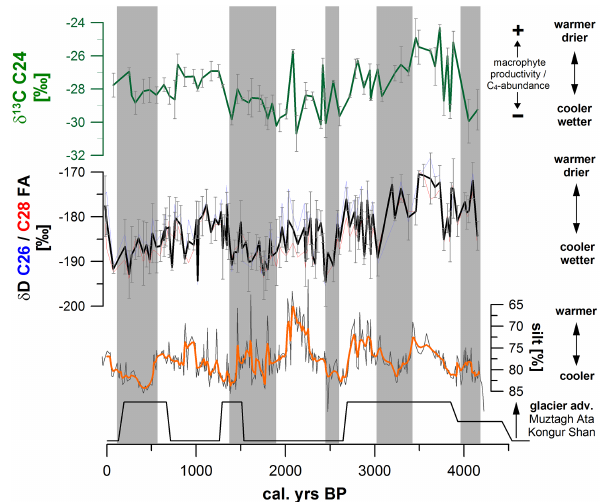
Figure 7. Summary of organic geochemical results from this study in the context of silt contents of the same sediment core (Liu et al., 2014; orange line: five-point weighted average) and data of local glacier advances inferred from 10 Be dating (Seong et al., 2009a; centers and widths of boxes mark the mean age and the error ranges of the events). Biomarker hydrogen isotopic data are presented as mean of triplicate measurements with 1 σ error bars for the C 26 (blue line) and C 28 n -alkanoic acids (red line), as well as un- weighted average of the two (thick black line). Shaded areas are relatively cool and wet episodes, based on leaf wax isotopic data.